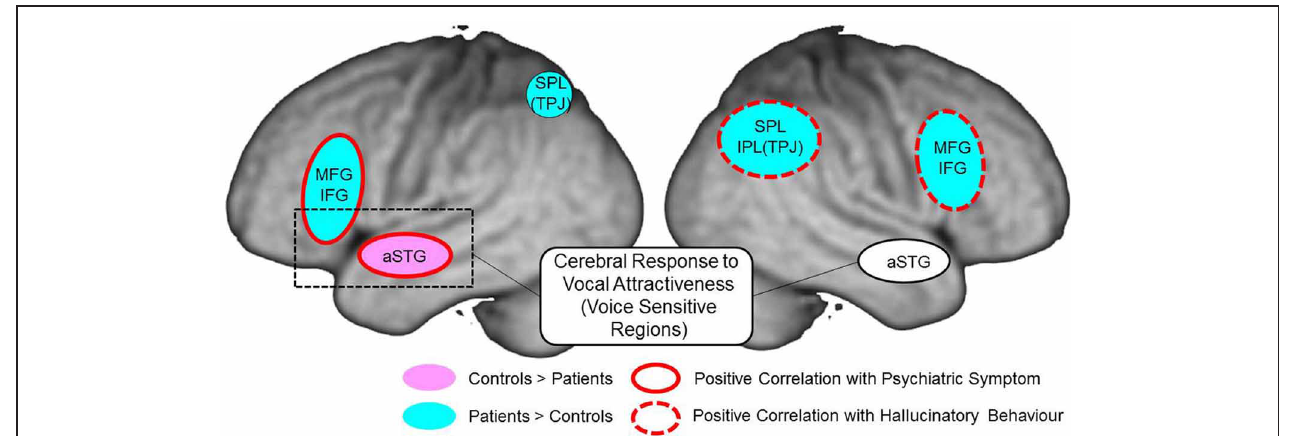
FIGURE 9 | Summary of cerebral response to auditory attractiveness and psychiatric symptom in schizophrenia: red circle shows the area of positive correlation between cerebral activation and total PANSS score; red dashed line shows the area of positive correlation between cerebral activation and hallucinatory behavior;